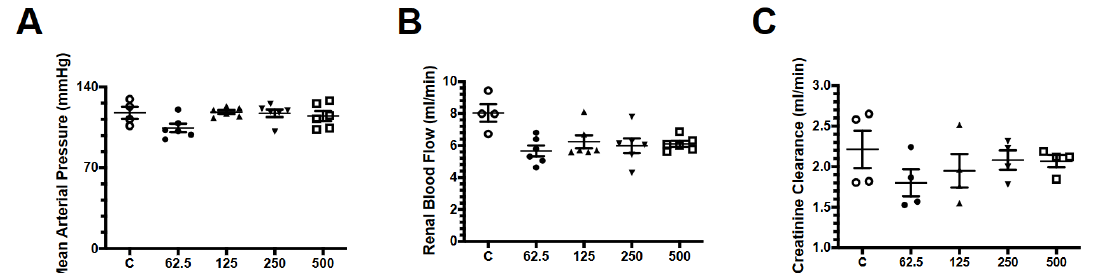
Figure 1. Effect of different fosfomycin doses on renal function. Five groups were studied: control (C, white circles, n = 4), fosfomycin 62.6 mg/kg (62.5, black circles, n = 6), fosfomycin 125 mg/kg (125, black triangles up, n = 6), fosfomycin 250 mg/kg (250, black triangles down, n = 6), and fosfomycin 500 mg/kg (500, white rectangles, n = 6). The treatments were given in three doses 48 h apart. After seven days, ( A ) mean artery pressure, ( B ) renal blood flow, and ( C ) creatinine clearance were determined.